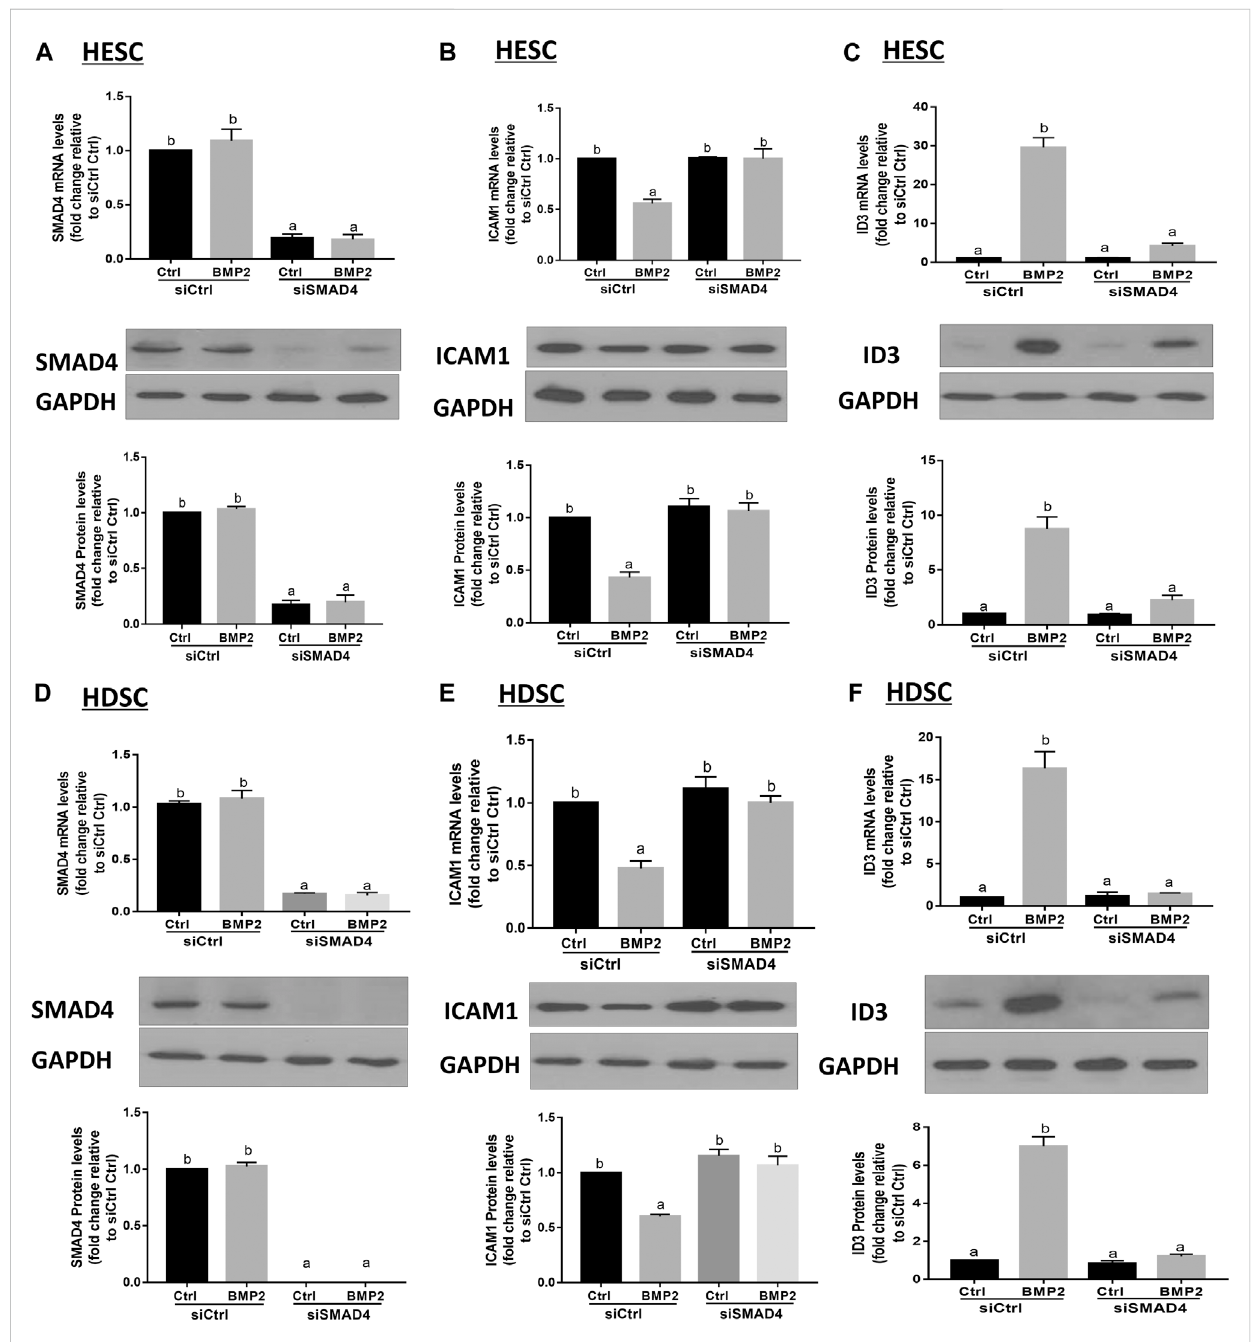
FIGURE 9 SMAD4 is involved in the BMP2-induced upregulation of ID3 expression and downregulation of ICAM1 expression in HESCs and HDSCs. (A – C) HESCs were transfected with 25 nMsiCtrl or 25 nM siRNA targeting SMAD4 (siSMAD4) for 48 h, and the cells were then treated with BMP2 (25 ng/mL) for an additional 24 h. The mRNA and protein levels of SAMD4 (A) , ICAM1 (B) and ID3 (C) were examined using RT-qPCR and Western blot analysis, respectively. (D – F) HDSCs were transfectedwith 25 nM siCtrl or 25 nM siSMAD4for 48 h, and the cells were then treated with BMP2 (25 ng/mL)for an additional 24 h. The mRNA and protein levels of SAMD4 (D) , ICAM1 (E) and ID3 (F) were examined using RT-qPCR and Western blot analysis. Respectively. The results are expressed as the mean ± S.E.M. of at least three independent experiments. Different letters indicate signi fi cant a difference ( p <